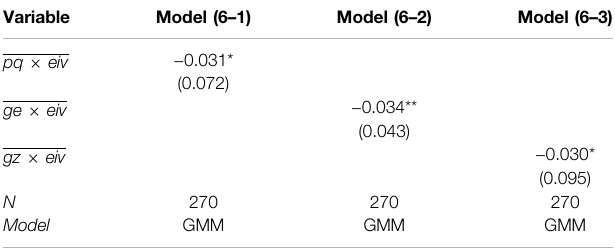
TABLE 7 | Extension results of